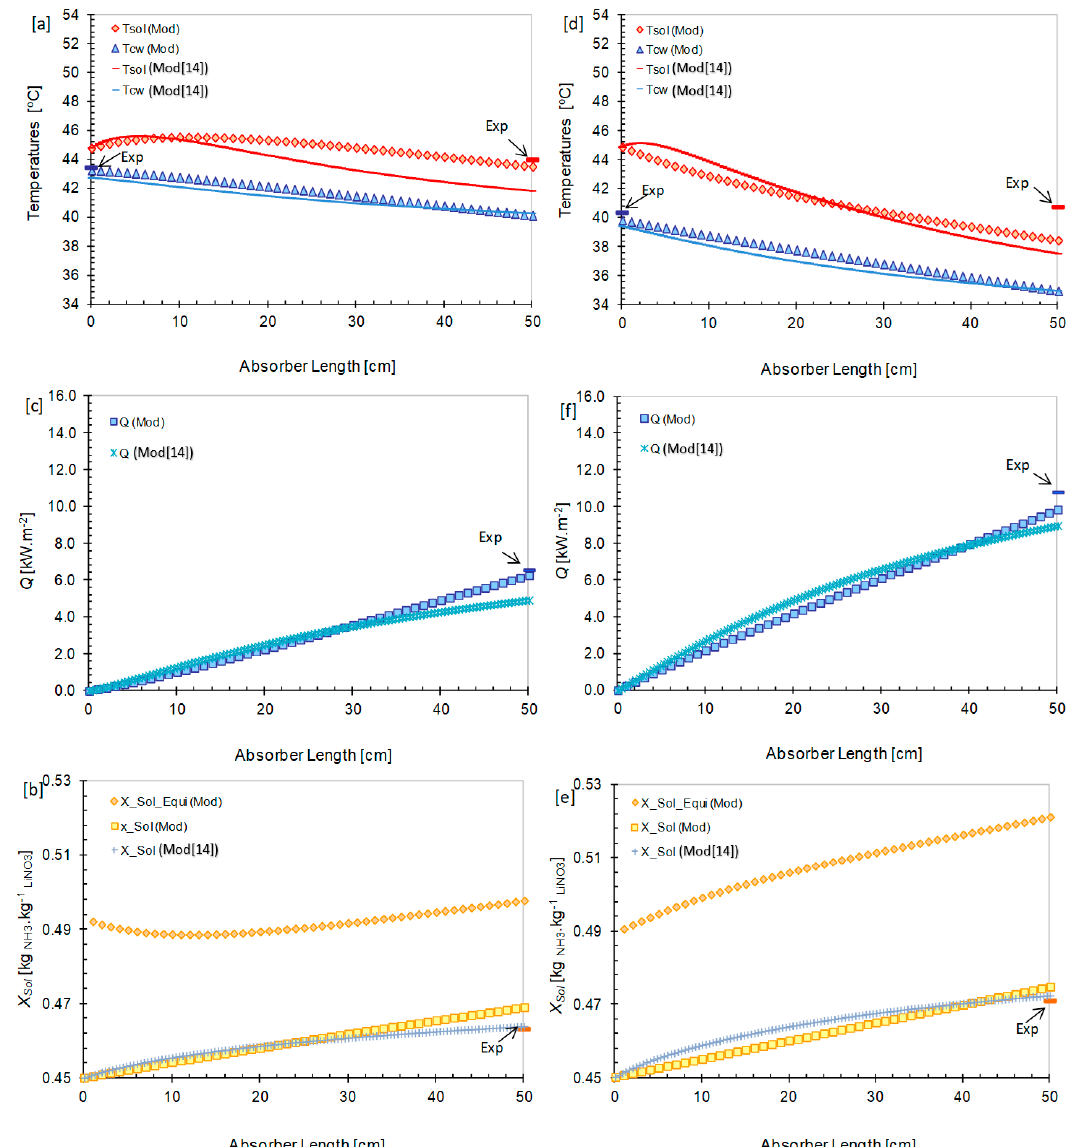
Figure 6. Profiles at a heat dissipation temperature of 40 °C for: ( a ) temperatures, ( b ) concentration, and ( c ) thermal load. Profiles at a heat dissipation temperature of 35 °C for: ( d ) temperatures, ( e ) concentration, and ( f ) thermal load.